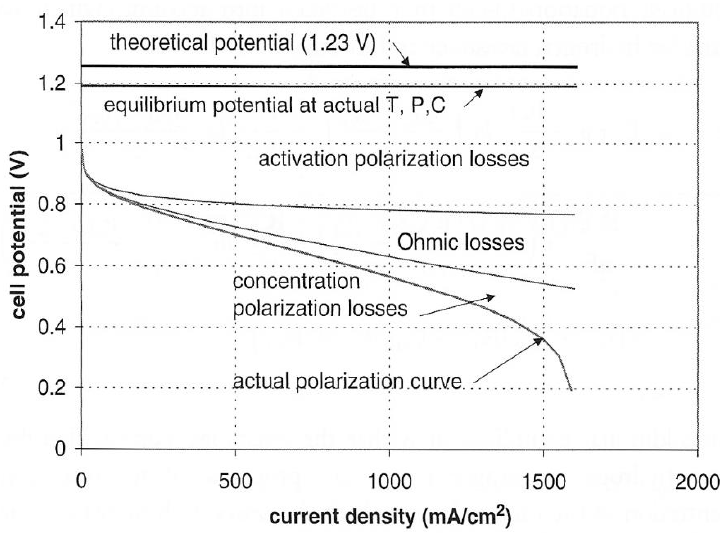
Figure 4. Cell potential as a function of the current density.